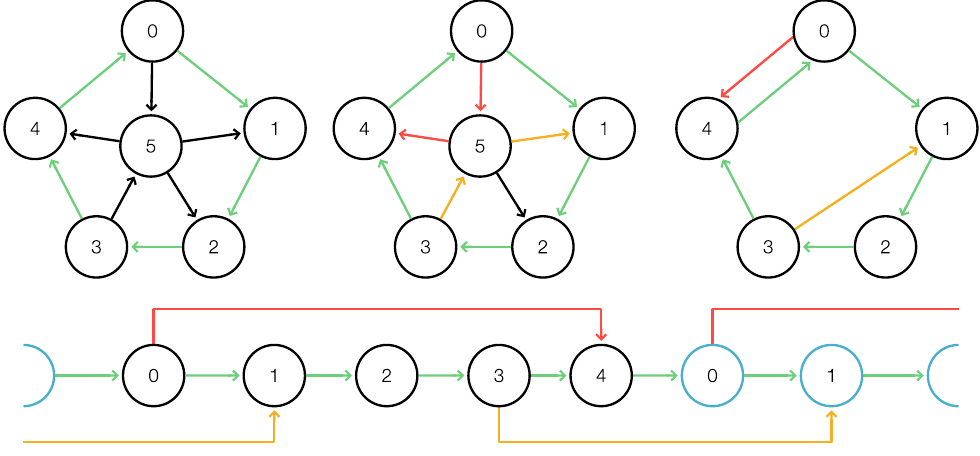
Figure 4. One-vertex cover. As in Figure 3, the cycle C and the C (cid:32) -paths are highlighted in green and red, respectively. The paths ( 0,5, 4 ) and ( 3,5, 1 ) imply that C ( 0,4 ) and C ( 3,1 ) are C (cid:32) -covered. It is a one-vertex cover conforming to Lemma